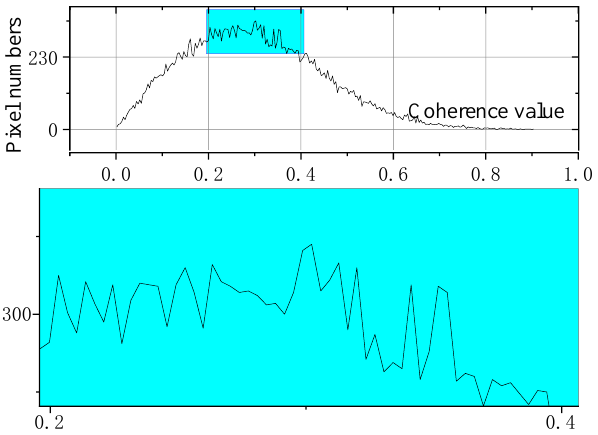
Figure 10. 2021.8.6 to 2022.4.3 SAR image coherence value and corresponding number of